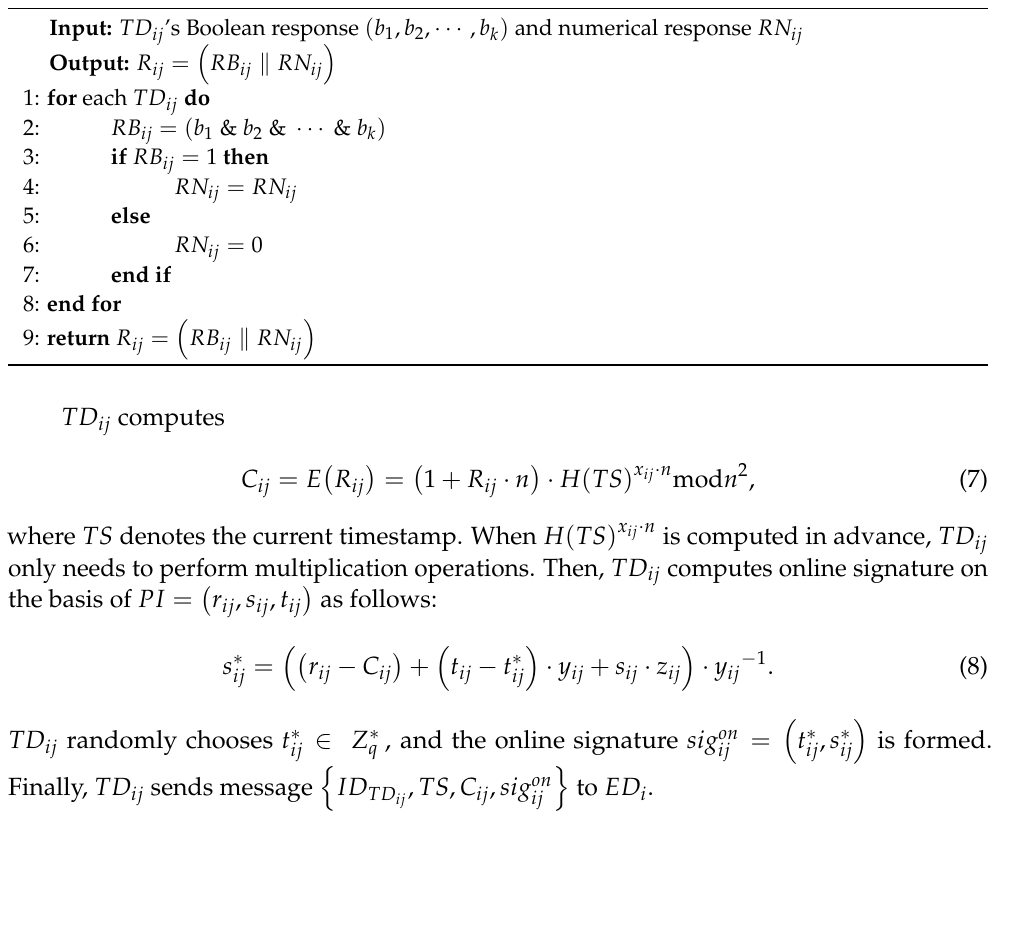
Algorithm 1: IoT devices